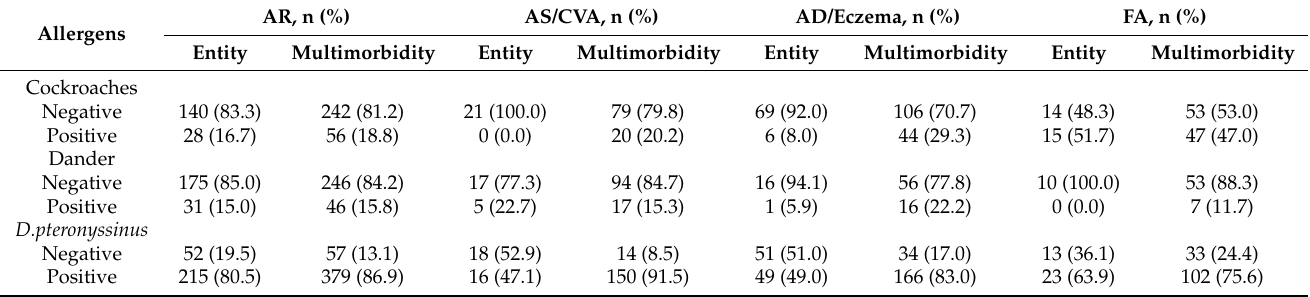
Table 3. Comparison of inhaled allergen sensitization between allergic multimorbidities against a single entity in four allergic